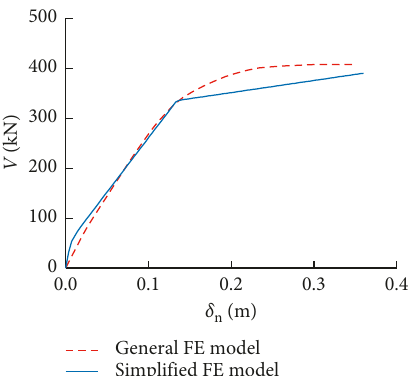
Figure 11: Capacity curves of the FSCW structure obtained using the two models.